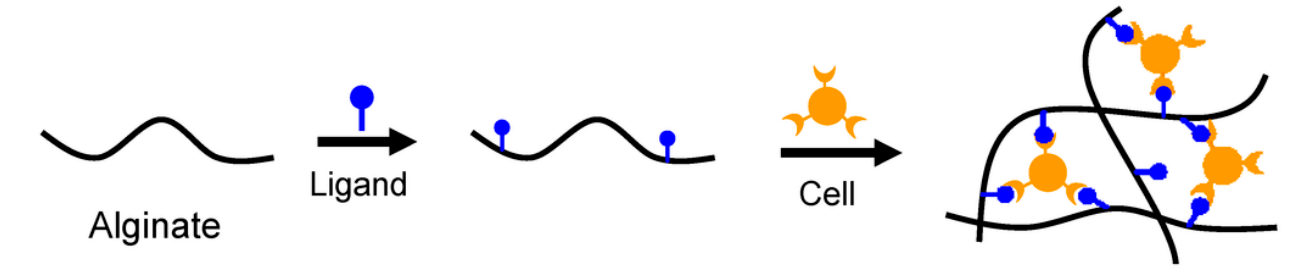
Figure 4. Representative mechanism of cells’ inclusion in an alginate network after coupling with a ligand, such as RGD cell-adhesion motif. Re-used from Sun, J.; Tan, H. Alginate-Based Biomaterials for Regenerative Medicine Applications. Materials 2013 , 6 , 1285–1309.